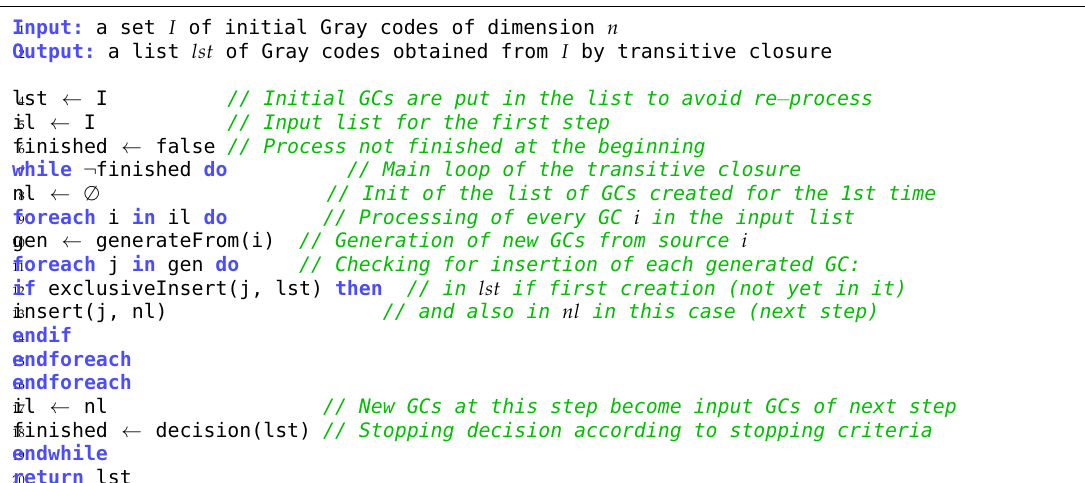
Algorithm 2: Transitive closure generation